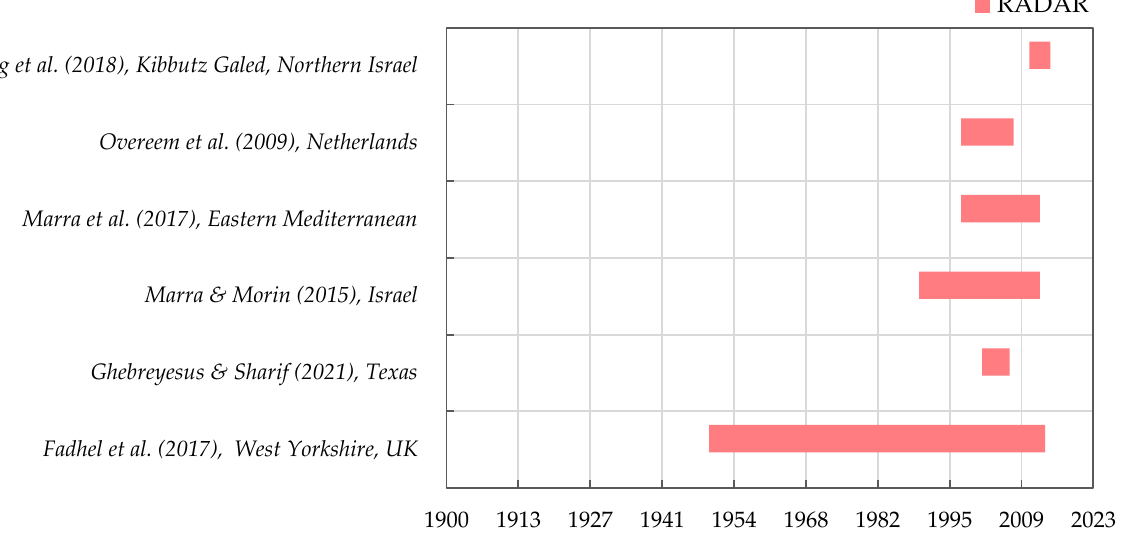
Figure 4. Years of coverage for each radar dataset [97 – 102]. Table 3. Papers developing IDFs using a radar dataset.